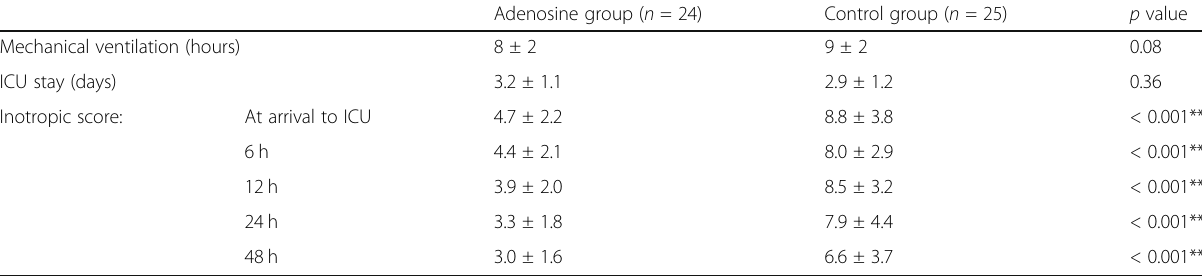
Table 2 Postoperative